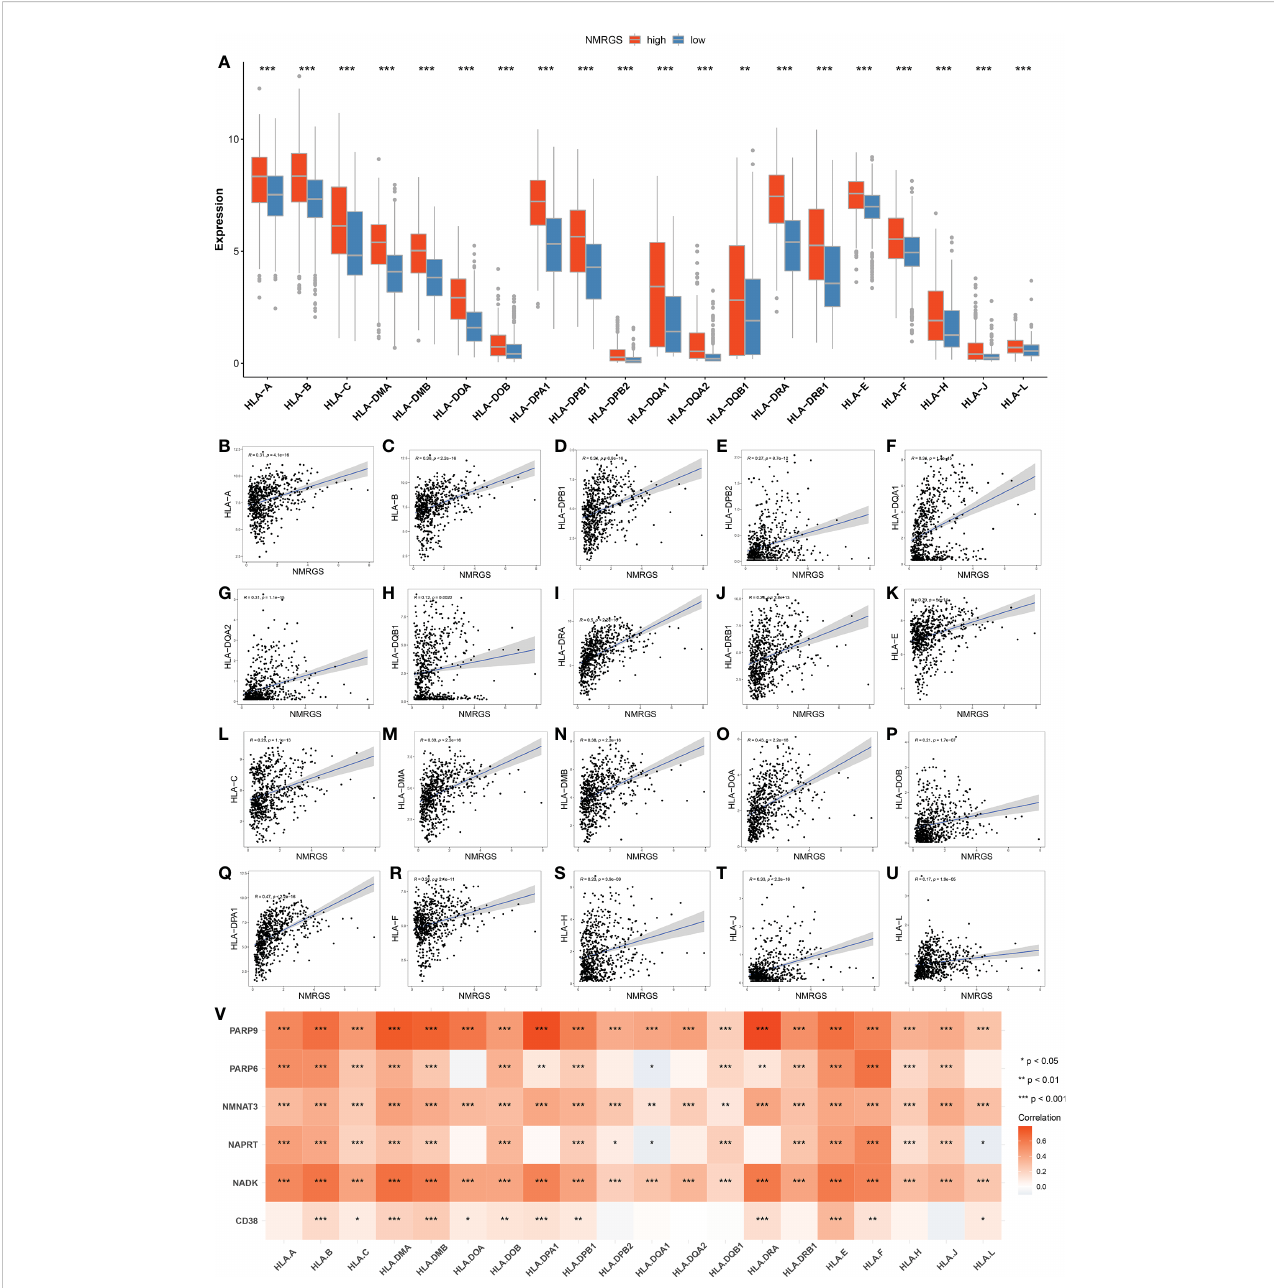
FIGURE 8 (A) Comparison of HLA molecules between NMRGS-low group and NMRGS-high group. (B – U) Correlations between HLA molecules and the NMRGS score. (V) Correlations between HLA molecules and the six hub